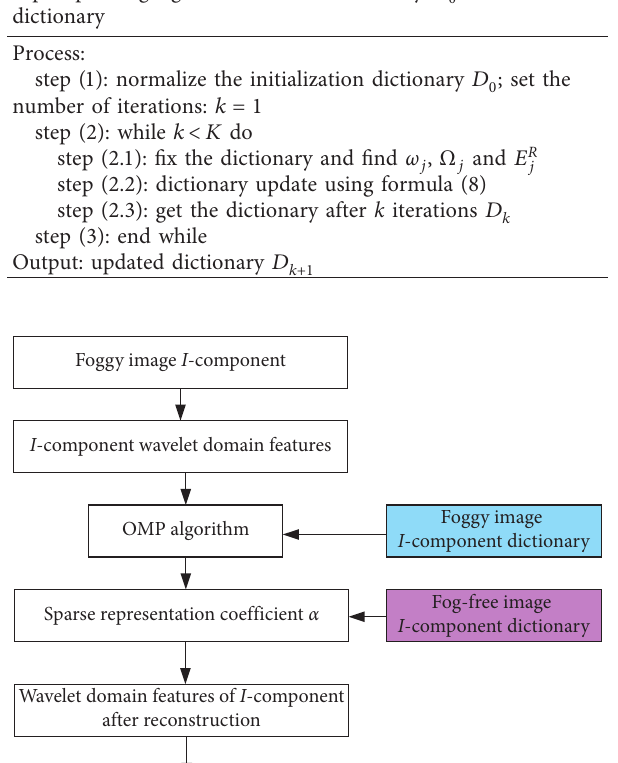
Table 1: K-SVD algorithm steps.